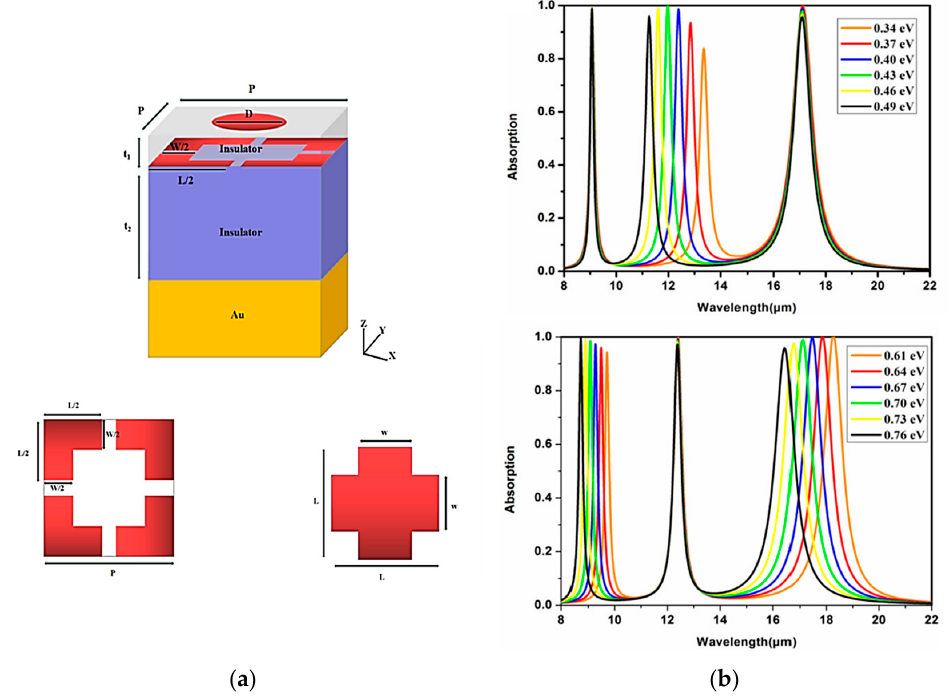
Figure 25. ( a ) Structure of graphene-based infrared band absorber and ( b ) corresponding absorption